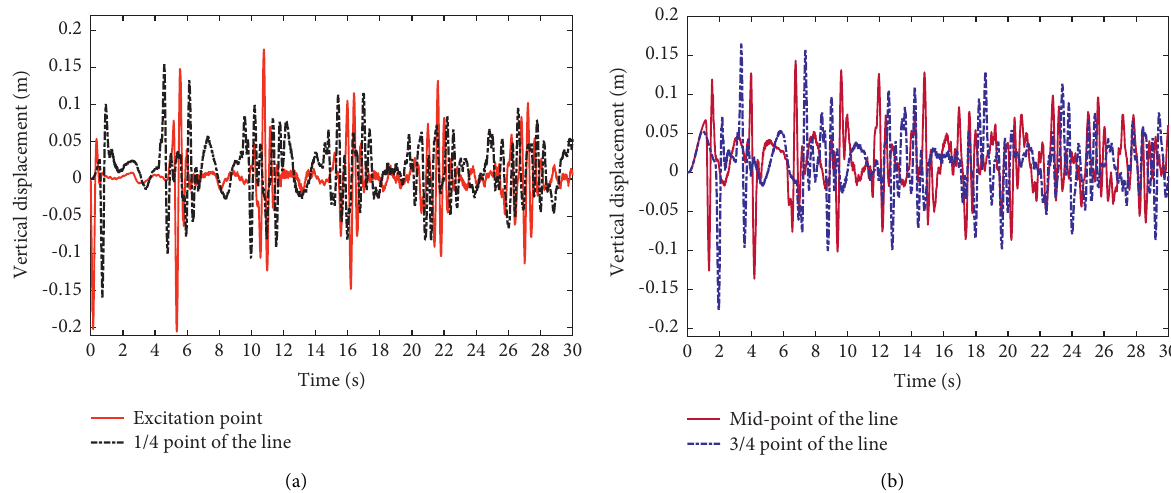
Figure 1: Displacement response after a single excitation. (a) Vertical displacement-time curve at the excitation point and 1/4 point of the line. (b) Vertical displacement-time curve at midpoint and 3/4 point of the